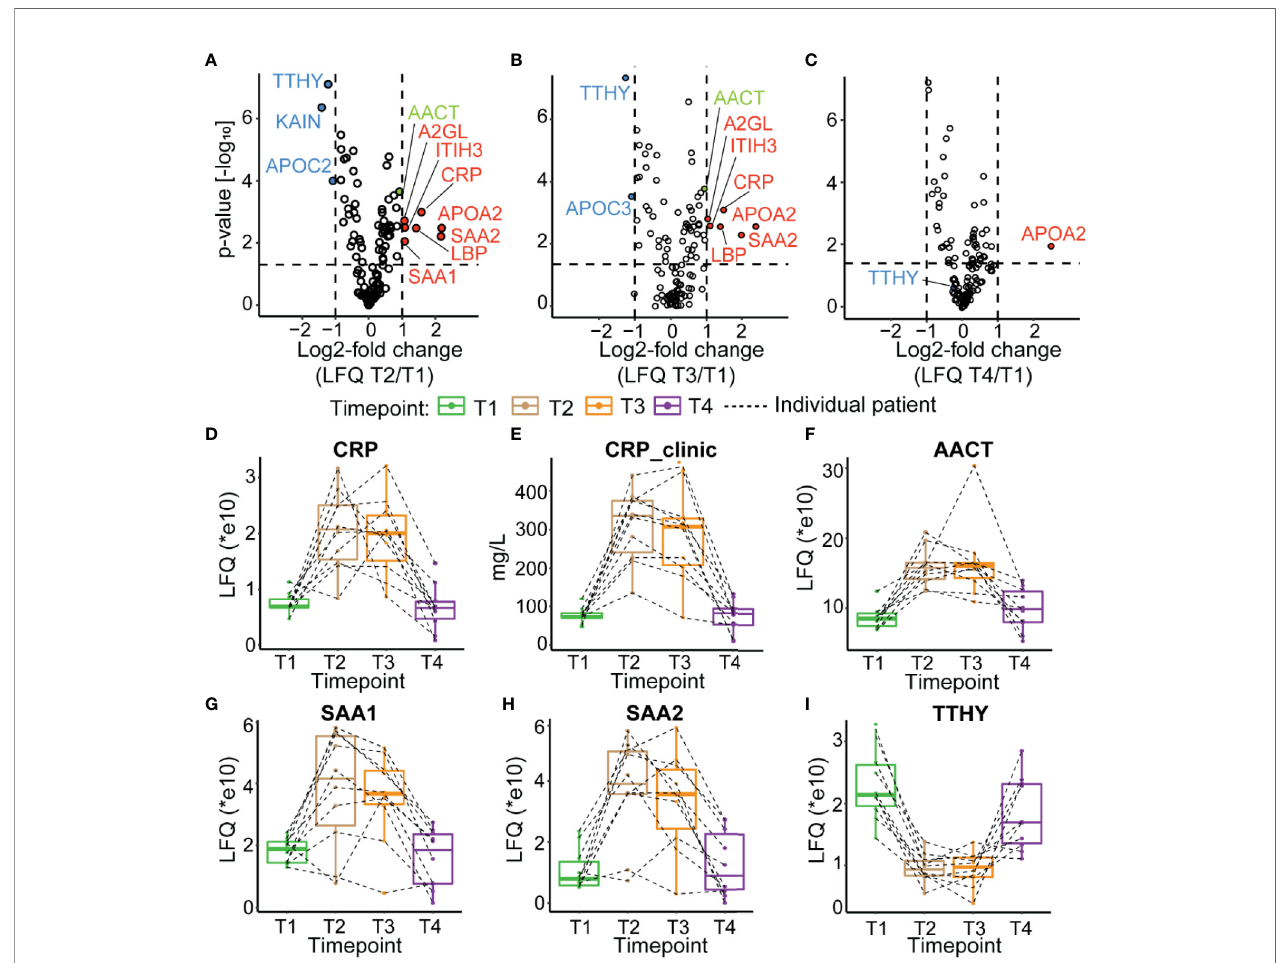
FIGURE 2 | Plasma proteome pro fi les of septic patients. Volcano plots depicting the changes in protein abundances, normalized against T1, for T2 in (A) , T3 in (B) , and T4 in (C) averaged over all ten patients. Proteins increasing in abundance are depicted in red, while proteins becoming lower in abundance are shown in blue. AACT is depicted in green. Dotted lines indicate thresholds for signi fi cance and fold change. (D) Proteomics based quantitation of CRP levels per individual patient. (E) CRP levels measured in the clinic. (F) Proteomics based quantitation of AACT per individual patient. Proteomics based abundance levels for SAA1, SAA2, and TTHY in all individual patients are depicted in (G – I) , respectively. The depicted boxplots contain data for all patients across all four time-points. The dashed lines connect for each individual patient its corresponding